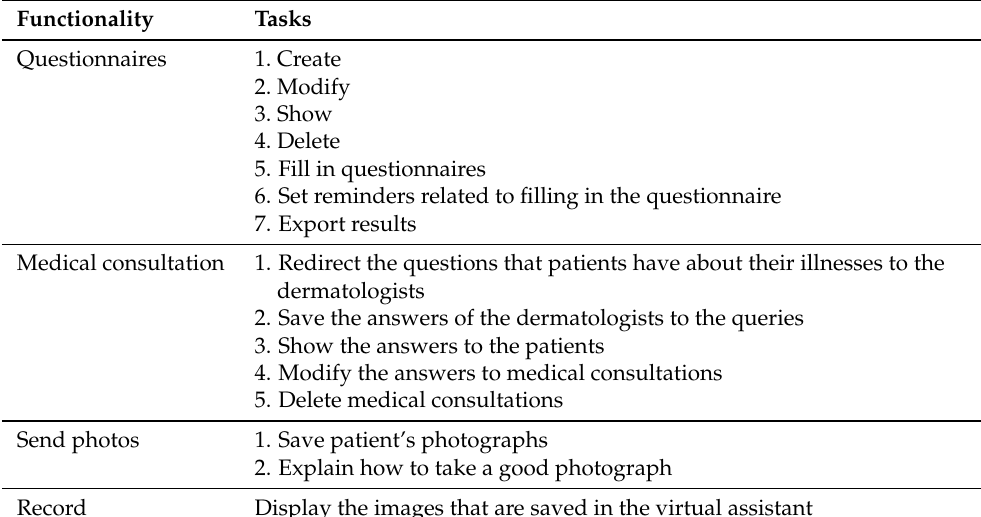
Table 1. Description of the virtual assistant functionalities used in the